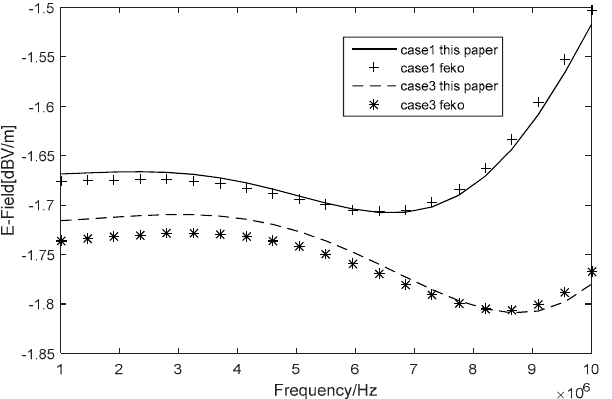
Figure 4. Electric field values with the frequency under different burial depths.